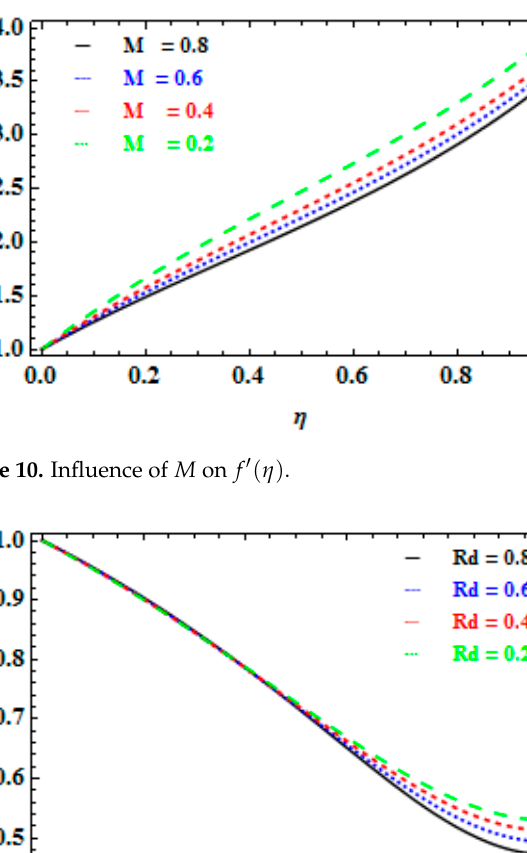
Figure 9. Influence of G r on 𝑓 (cid:4593) ( 𝜂 ) .